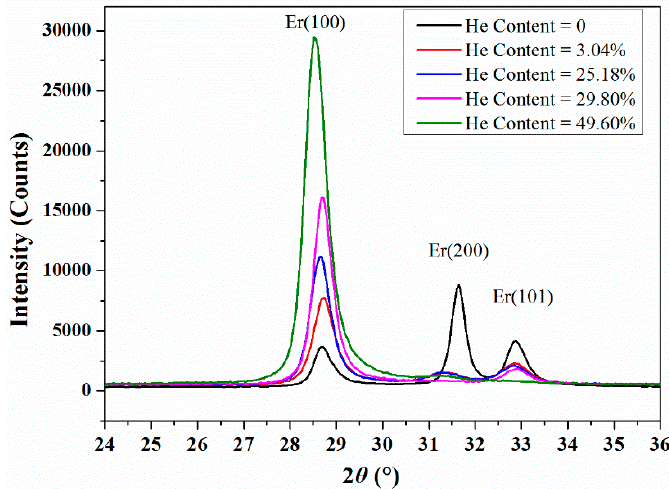
Figure 2. X-ray di ff raction (XRD) patterns of the Er films deposited with di ff erent flow ratio of Q He / Q Ar . Figure 2. X-ray diffraction (XRD) patterns of the Er films deposited with different flow ratio of Q He /Q Ar .